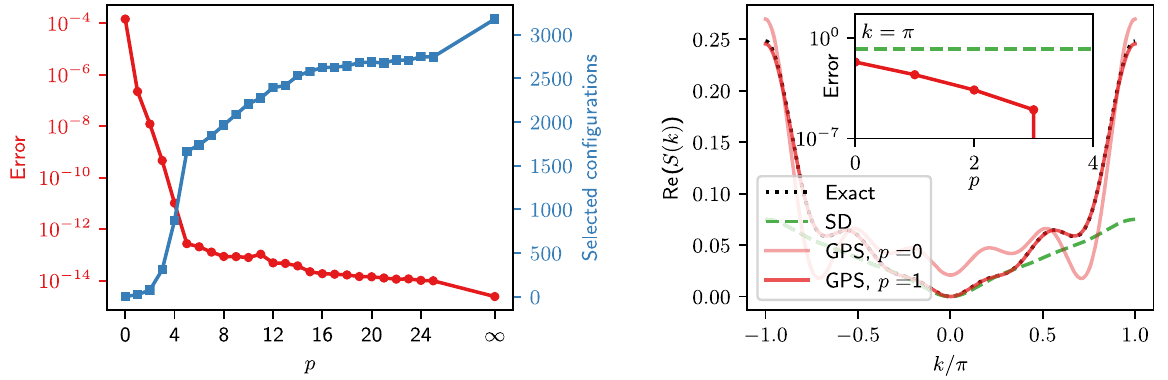
FIG. 2. Left panel: Mean-squared GPS amplitude error for the ground state of the 10-site, half-filled 1D Hubbard chain at U ¼ 8 t , as the kernel power hyperparameter is varied ( p , with θ ¼ 0 ). Also shown is the size of the training set of configurations selected by the RVM from the exact data to construct the GPS with this underlying kernel complexity. Right panel: Real part of the spin structure factor Re ( S ð k Þ ) corresponding to the exact wave function (black dotted line), the GPS with p ¼ 0 and p ¼ 1 (red solid line), and the single Slater determinant representation obtained with the Hartree-Fock method (green dashed line) for the same system. The inset shows the absolute error of Re ( S ð k ¼ π Þ ) for the GPS with respect to the kernel hyperparameter p , as well as the error obtained for a single Slater determinant